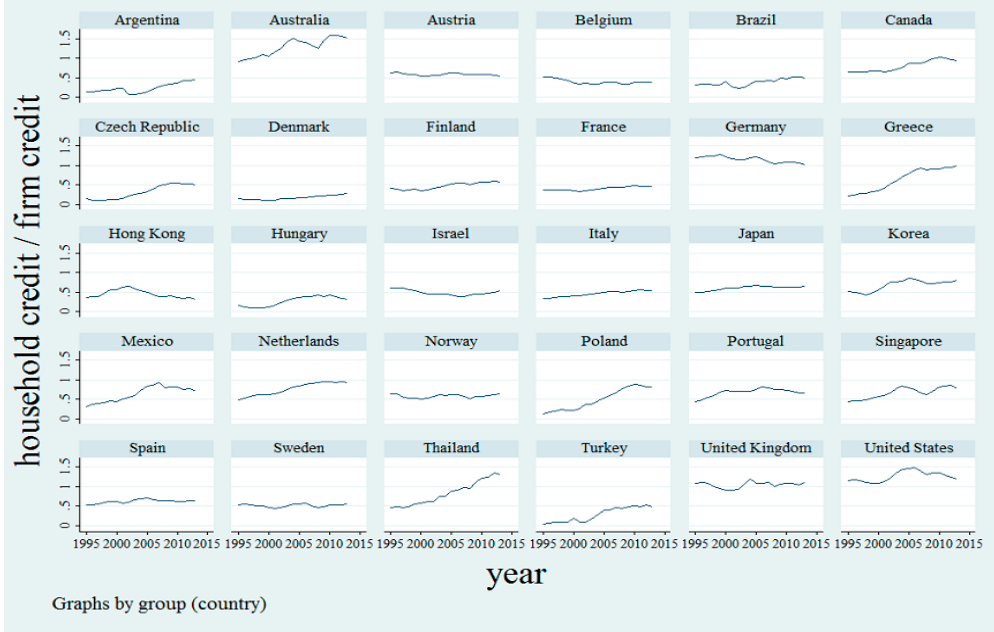
Figure 1. The Ratio of Household Credit to Firm Credit (Annual Data, 1995–2013). Source: Bank for International Settlements (BIS) and Authors’ calculations.